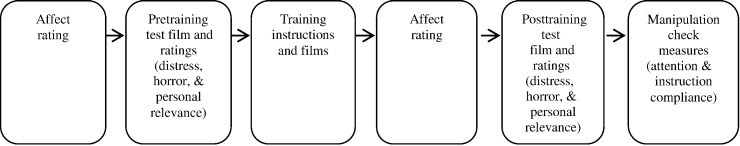
Overview of film task.